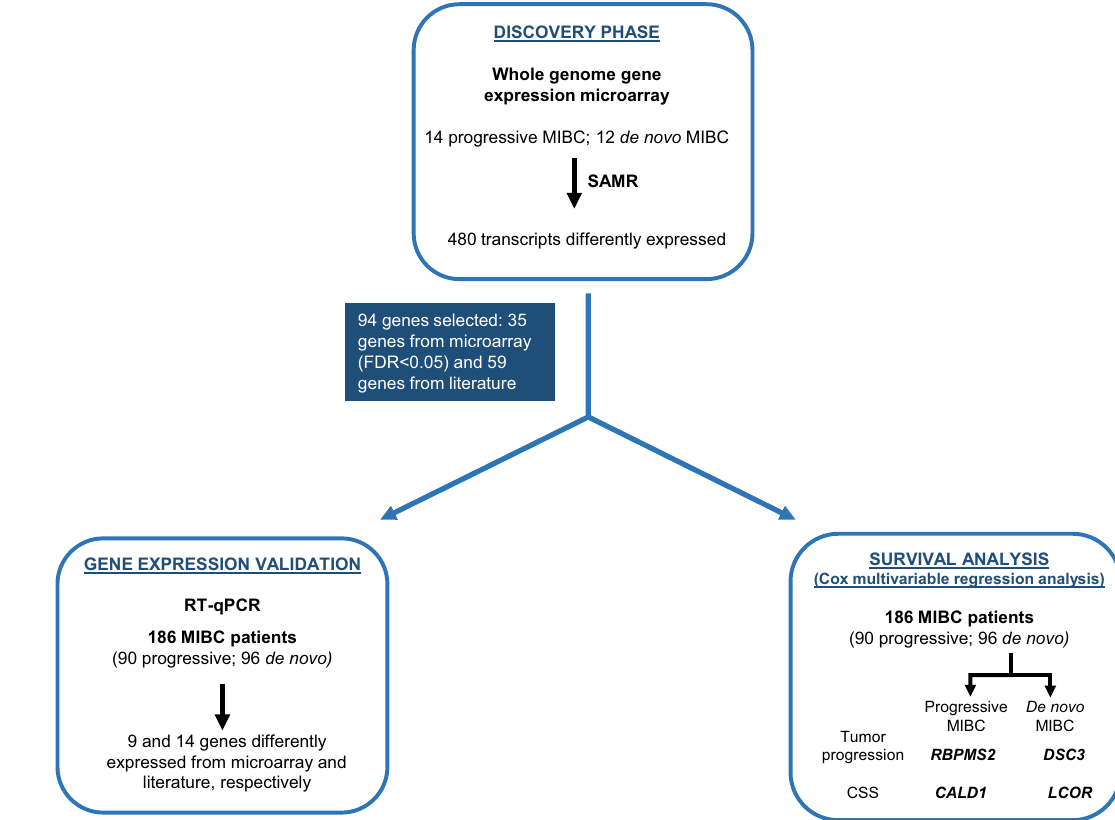
Figure 4. Study outline. Tissue samples were obtained from a total of 104 progressive and 108 de novo MIBC patients. Samples were split into a discovery (26 samples) and validation phase (186 samples). Genes differently expressed between progressive and de novo MIBC patients were identified in the discovery phase by using gene expression microarray. None of the samples from the discovery phase were employed for the validation process. In this validation phase, the differential expression of 94 genes was evaluated. In survival analysis, RBPMS2 and DSC3 were identified as prognostic biomarkers for tumor progression in progressive and de novo MIBC, respectively; CALD1 and LCOR were identified as prognostic markers for CSS in progressive and de novo MIBC, respectively. CSS Cancer specific survival, FDR False discovery rate, SAMR Significance analysis of